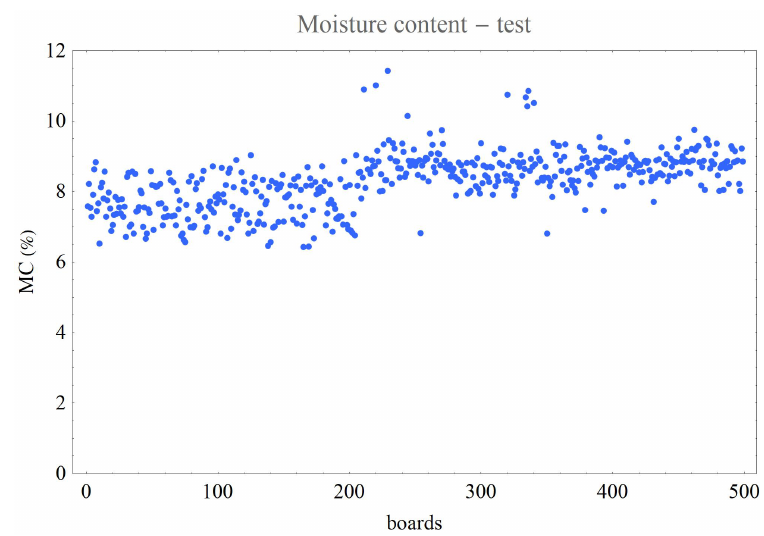
Figure 12. Moisture content of boards during testing.